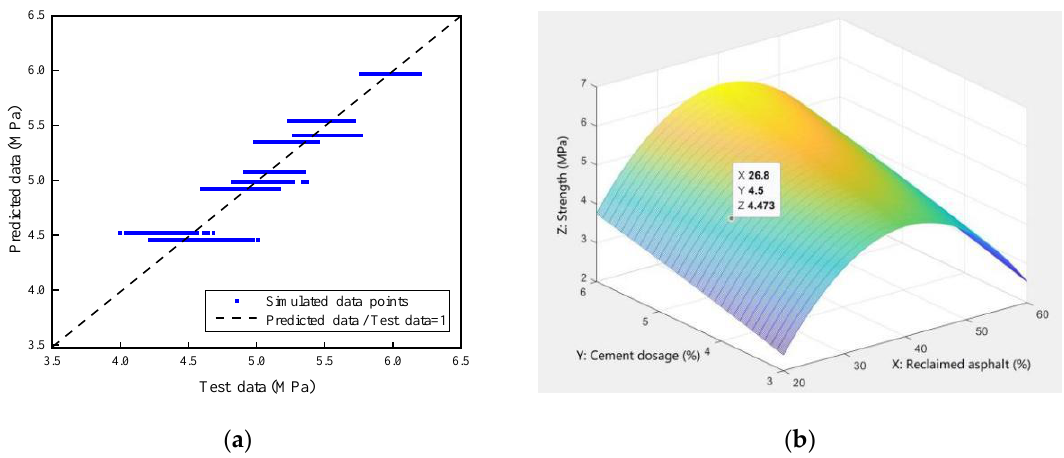
Figure 23. Numerical simulation of compressive strength: ( a ) Monte Carlo simulation; ( b ) 3D diagram of the nonlinear strength-fitting equation.